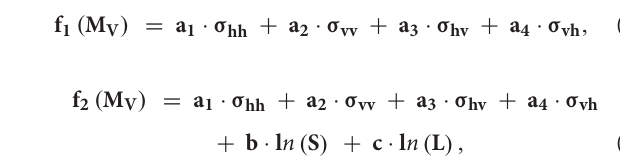
Furthermore, the independent test dataset is used to assess the final models’ performance and the metrics are shown in Figure 4